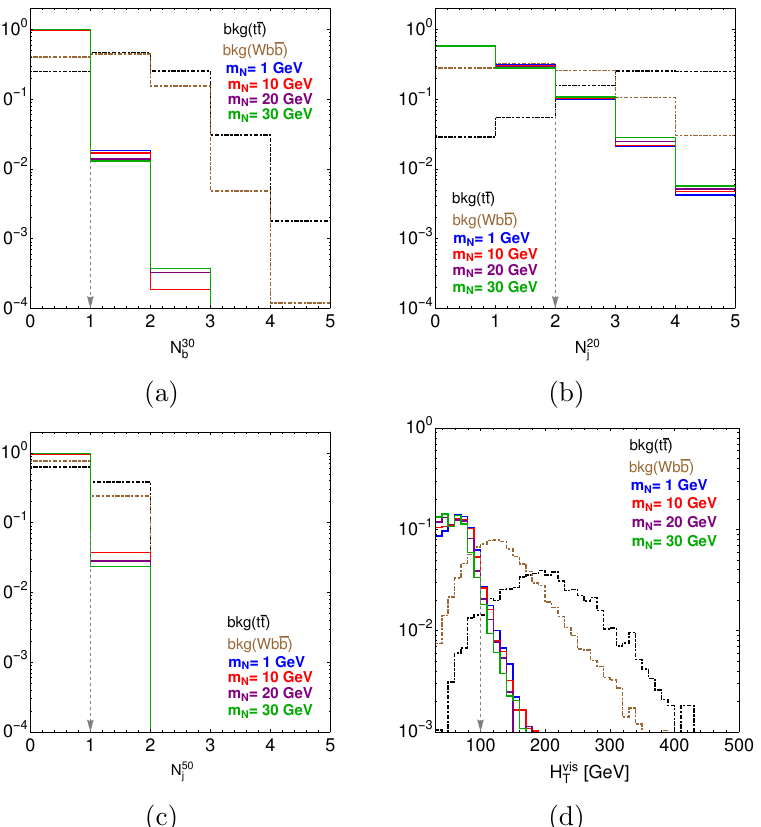
Figure 4 . The normalized distribution for the number of b-jets with p b > 30 GeV denoted as N 30 , T b the number of jets with p j > 20 GeV denoted as N 20 , the number of jets with p j > 50 GeV denoted j T T as N 50 and H vis , where H vis is the scalar sum of p T for all visible objects, including hadronic jets j T T and leptons. The two SM backgrounds t (cid:22) t ! b (cid:22) b + ‘ + X and W + b (cid:22) b; W ! ‘(cid:23) are dot-dashed lines with black and brown color respectively. The signals are solid lines with blue, red, purple and green colors for increasing m N . The dashed gray lines with arrow indicates the optimization cuts that the events to its left are retained, namely N 30 = 0, N 20 < 2, N 50 = 0 and H vis < 100 GeV. The j j T b above cuts have been applied after its distribution have been shown in (cid:12)gure (a), (b), (c), and (d).